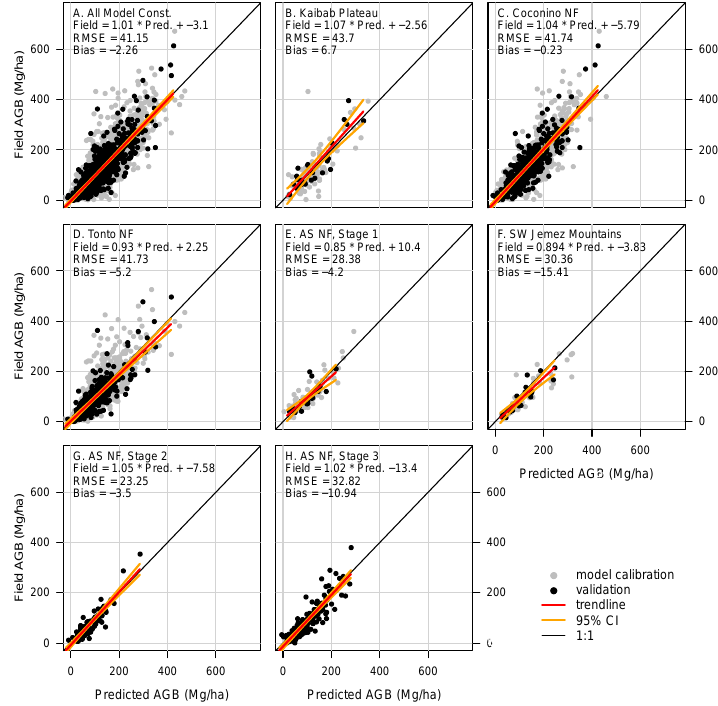
Figure 3. Scatter plot of the field-measured AGB vs. the predicted values from the trimmed median probability model (Table 6). Plots include data from: ( A ) all calibration and validation data used during model construction (data in plots b-f); ( B ) Kaibab Plateau, ( C ) Coconino N.F. (4FRI); ( D ) Tonto N.F. (4FRI); ( E ) Apache-Sitgreaves N.F. (4FRI) Stage 1; ( F ) Southwest Jemez Mountain; ( G ) transfer validation data from the Stage 2 Apache-Sitgreaves N.F. (4FRI) project; and ( H ) transfer validation data from the Stage 3 Apache-Sitgreaves N.F. (4FRI) project. Red and orange lines depict the linear fit and 95% confidence interval band of field-measured AGB versus predicted values, fit to the model validation data subset. Black line is 1:1. Table 7. Trimmed median probability model validation statistics. RMSE, percent RMSE, bias and percent bias were all calculated on the independent validation data